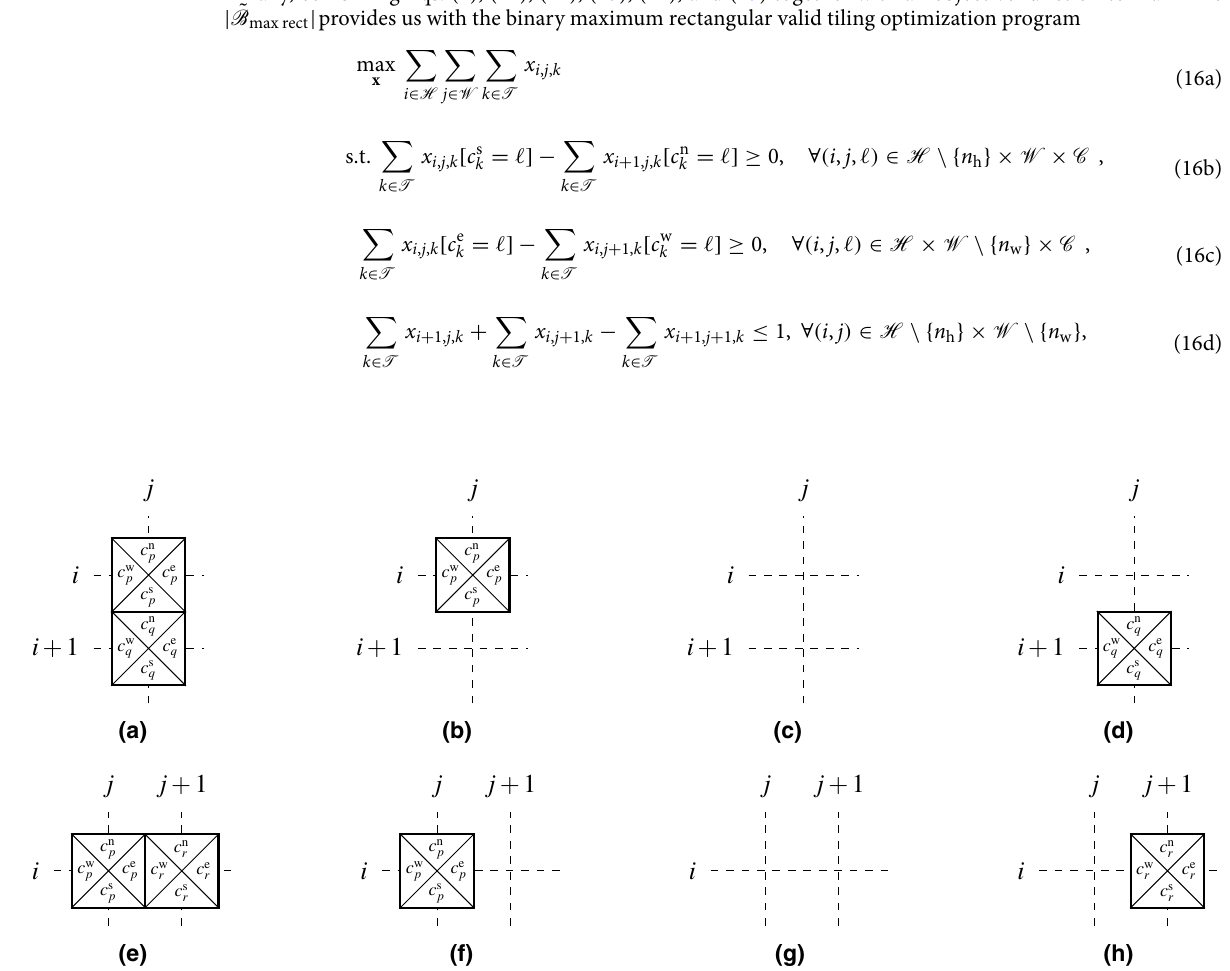
Figure 5. Admissible tile placements ( a )–( c ) and ( e )–( g ), and forbidden placements ( d ) and ( h ) in the maximum rectangular valid tiling